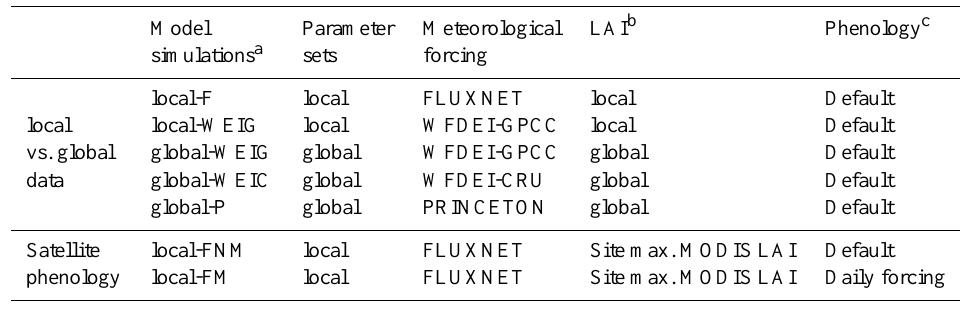
Table 3. Types of model simulations performed in this